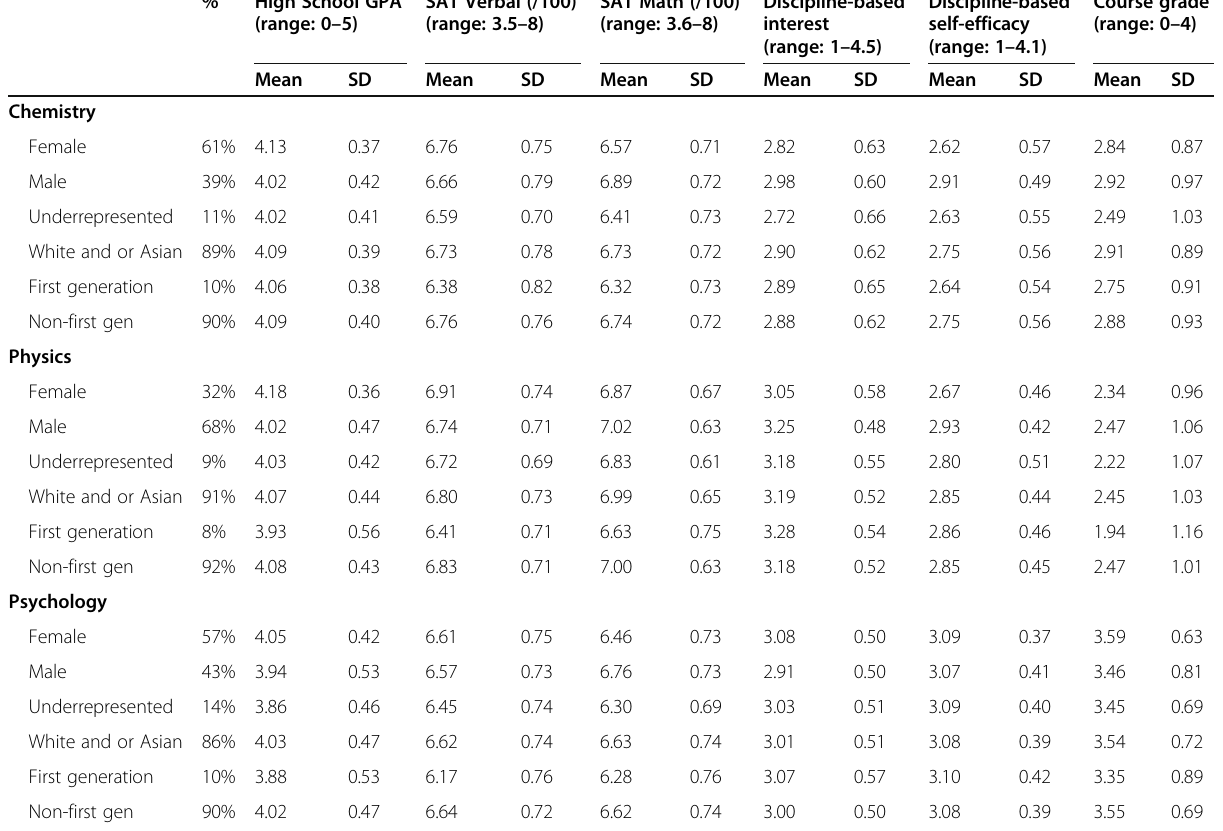
Table 3 Mean and SD for academic resources and discipline-specific motivational attitudes by course and demographic characteristics